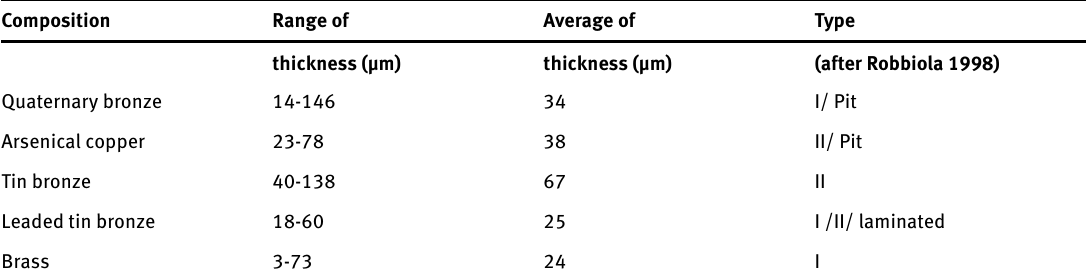
Table 1. The thickness of the corrosion layer in regard to the type of copper-alloy (based on Constantinides et al. 2002, 100). Composition Range of Average